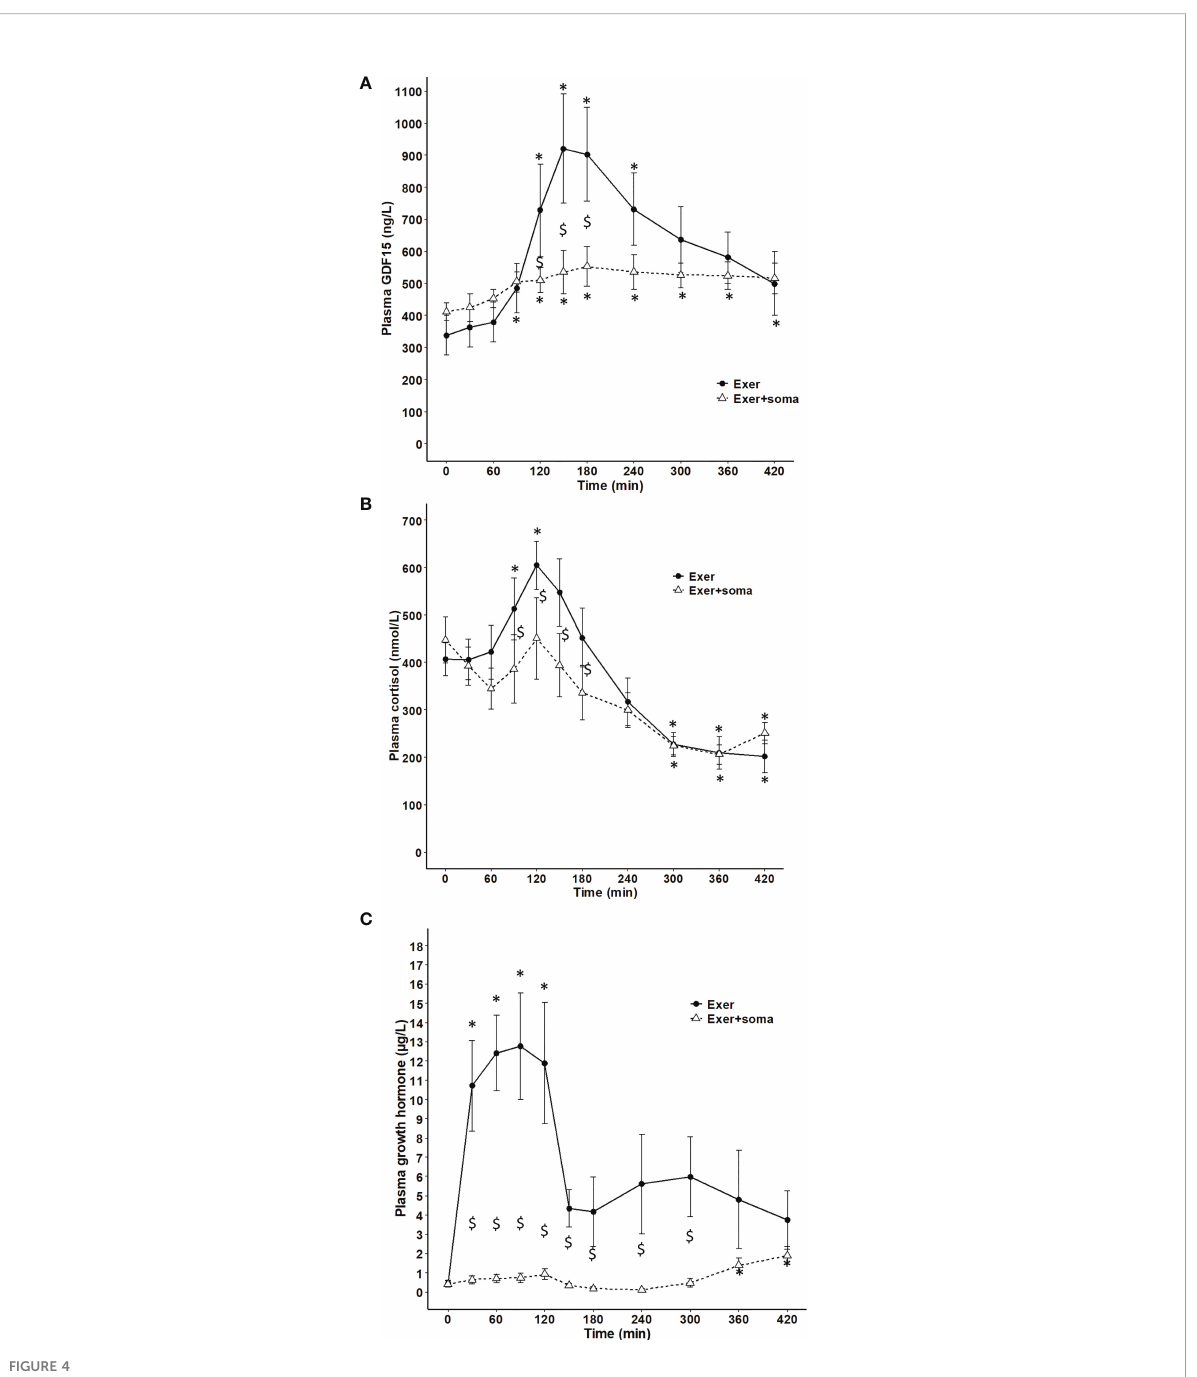
FIGURE 4 Plasma GDF15 and cortisol in 6 healthy males performing 2 hours of cycling exercise on 2 separate days with no infusion (black line) or with infusion of somatostatin (broken line). (A) plasma GDF15 (two-way ANOVA: Time P< 0.0001, Group P=0.0013, TimexGroup P= 0.0044). (B) plasma cortisol (two-way ANOVA: Time P< 0.0001, Group P=0.0028, TimexGroup P= 0.0877). (C) plasma growth hormones (two-way ANOVA: Time P< 0.0001, Group P< 0.0001, TimexGroup P< 0.0001). Data are presented as means +/- SEM. * signi fi cantly different from timepoint “ 0 ” , P < 0.05 and “ $ ” signi fi cantly different from control, P < 0.05. Plasma concentrations of insulin, glucagon and glucose are published in reference